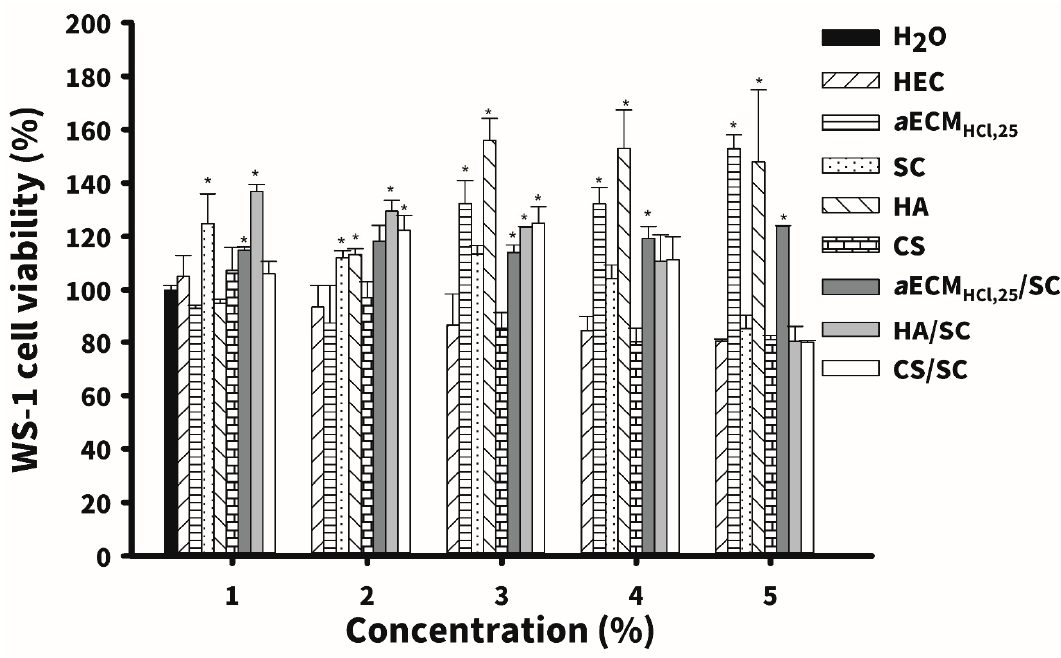
Figure 5. Cell viability ( n = 3) of WS-1 human skin fibroblasts incubated with five kinds of hydrogel dressings including hydroxyethyl cellulose (HEC), sacchachitin (SC), chitosan (CS) and hyaluronic acid (HA and a ECM HCl,25 and three kinds of composite hydrogel including a ECM HCl,25 / SC, HA / SC and CS / SC at a concentration of 0.005%, 0.01%, 0.05%, 0.1% and 0.5% for 72 h. Values are presented as the mean ± standard deviation. * p < 0.05, compared to H 2 O.